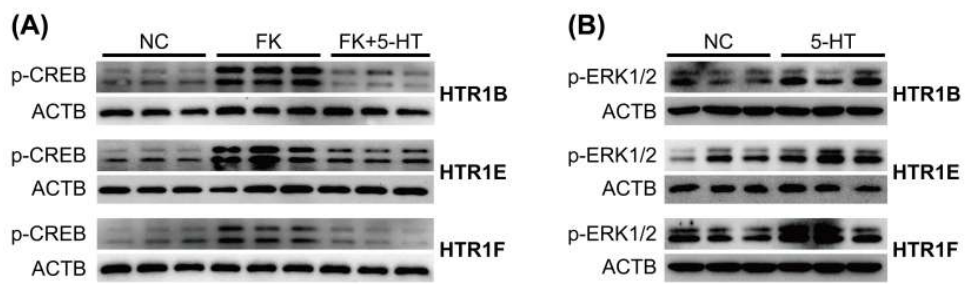
Figure 5. Western blot showing 5-HT treatment (100 nM, 10min) can inhibit the forskolin (FK) (2 µ M)-stimulated phosphorylation levels of CREB (p-CREB) in HEK293 cells expressing chicken HTR1B, HTR1E, and HTR1F ( A ), and 5-HT treatment (10 µ M, 10 min) can enhance phosphorylation of ERK1/2 (p-ERK1/2) in HEK293 cells expressing chicken HTR1B, HTR1E, and HTR1F ( B